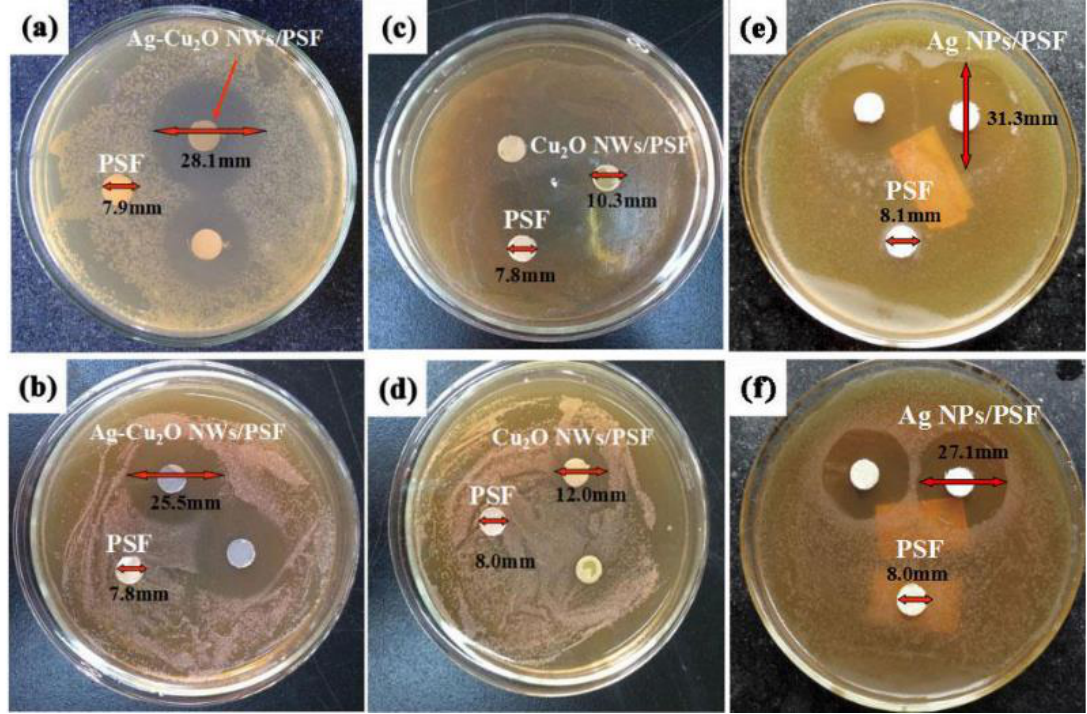
Figure 12. Inhibition zone of membranes with ( a , c , e ) E. coli and ( b , d , f ) S. Aureus [137].